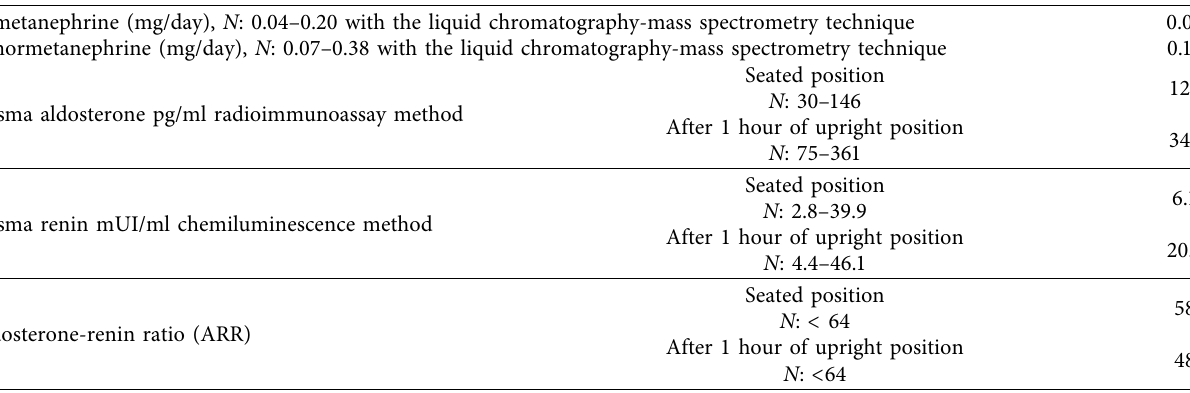
Table 1: Value of U-metanephrine, U-normetanephrine, the plasma renin, and the plasma aldosterone concentration. U-metanephrine (mg/day), N : 0.04–0.20 with the liquid chromatography-mass spectrometry technique 0.07 U-normetanephrine (mg/day), N : 0.07–0.38 with the liquid chromatography-mass spectrometry